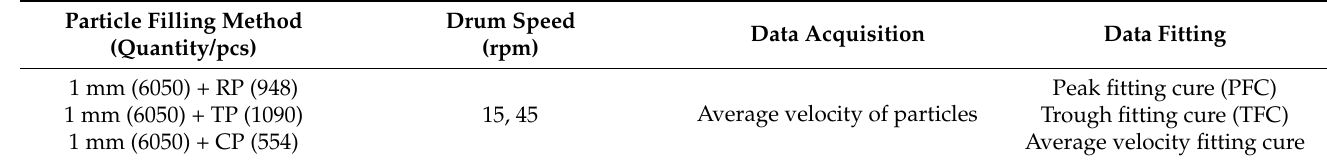
Table 3. Experimental conditions, data acquisition, and fitting.